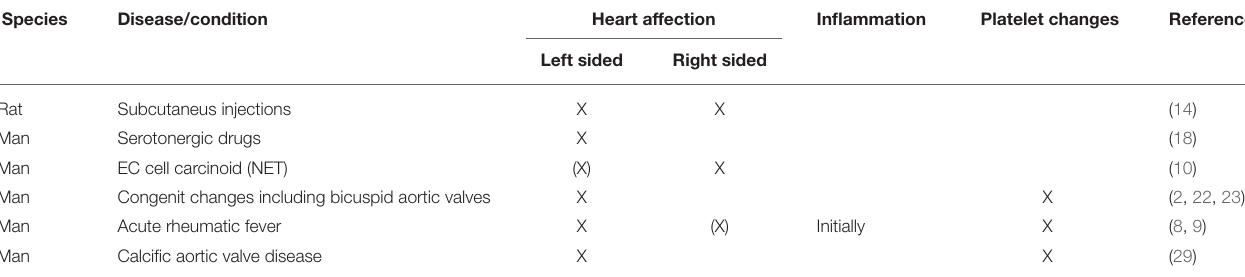
TABLE 1 | Serotonin and heart valve disease.